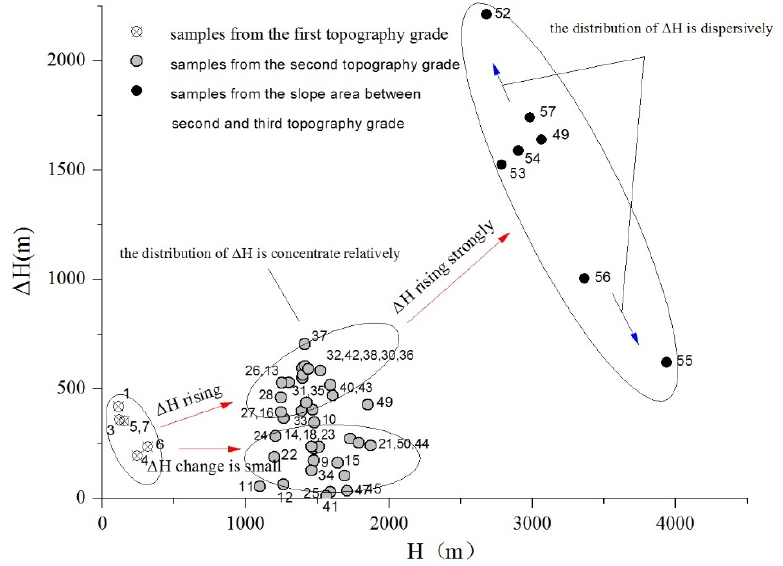
Figure 9. Elevation difference between supply area and appearing area of water samples.